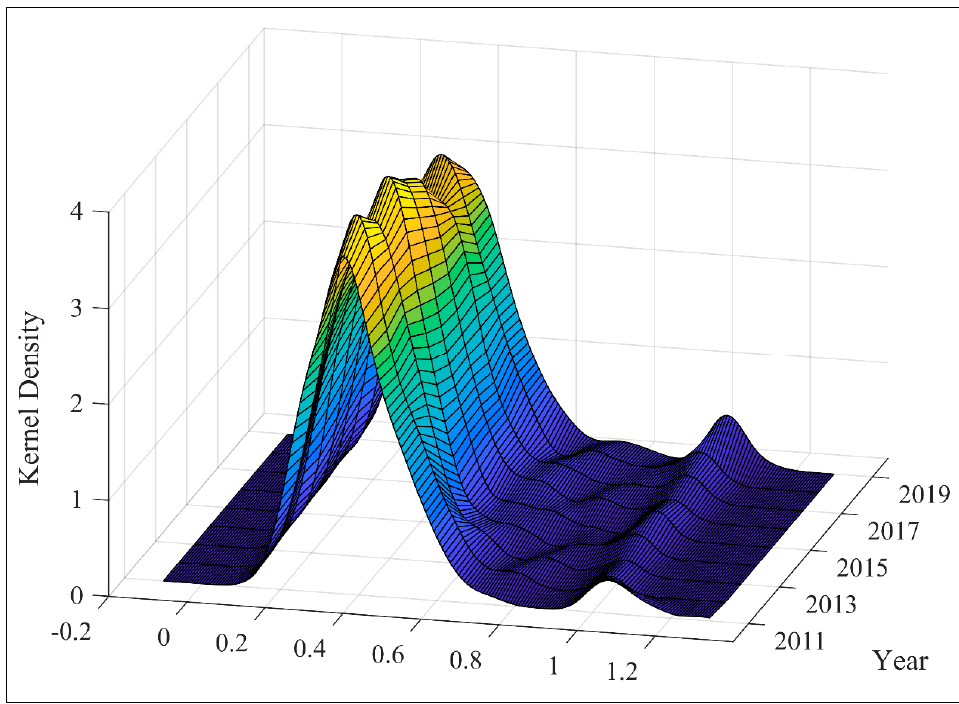
Figure 2. The kernel density distribution of Urban CCEP from 2011 to 2019. Besides, to alleviate the potential contemporaneous reverse causality and fully consider the lag impact of the DF index on China’s CCEP, the one phase lag of DF (L.DF) is